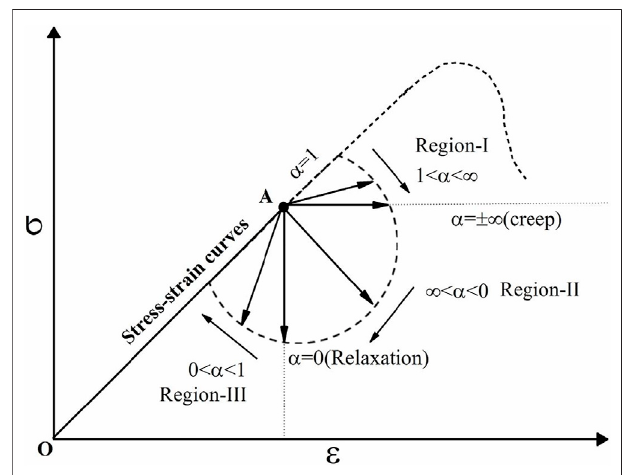
FIGURE 1 | Schematic diagram of generalized